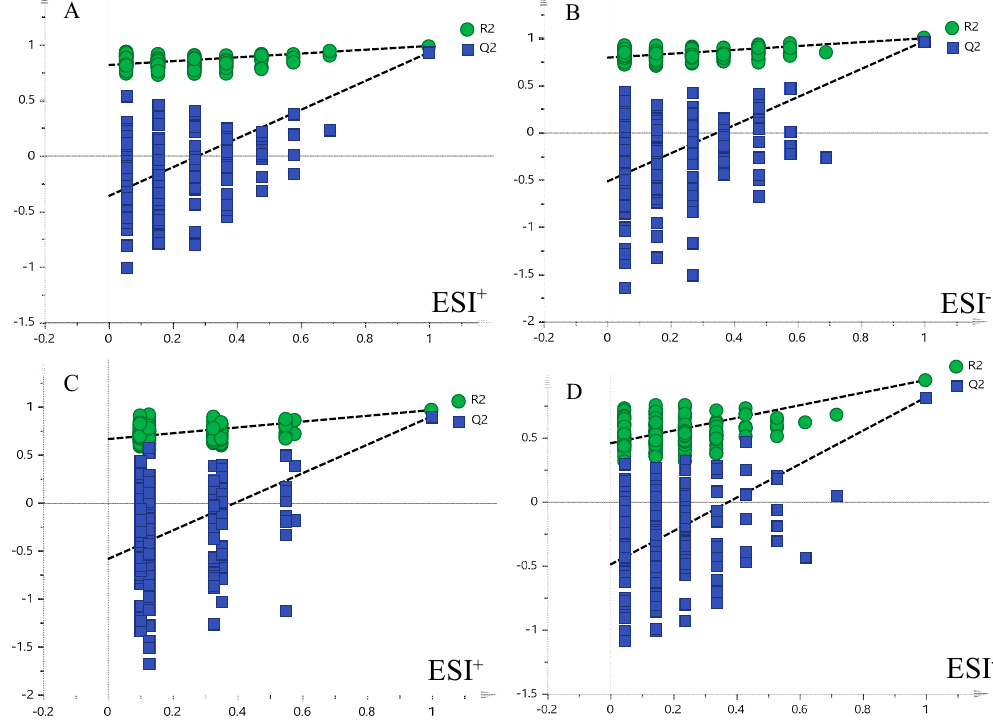
Figure 5. The permutations plots of the OPLS-DA models of urine ( A , B ) and plasma ( C , D ), respectively.